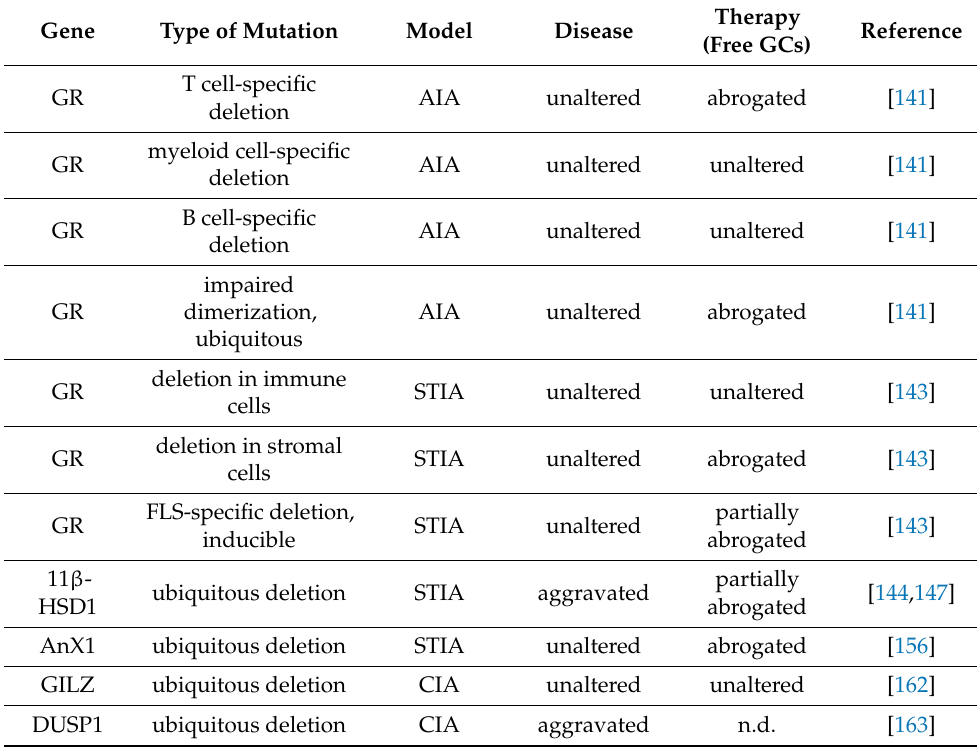
Table 4. Phenotype of selected genetic mouse models of RA. AnX1: Annexin A1. n.d.: not